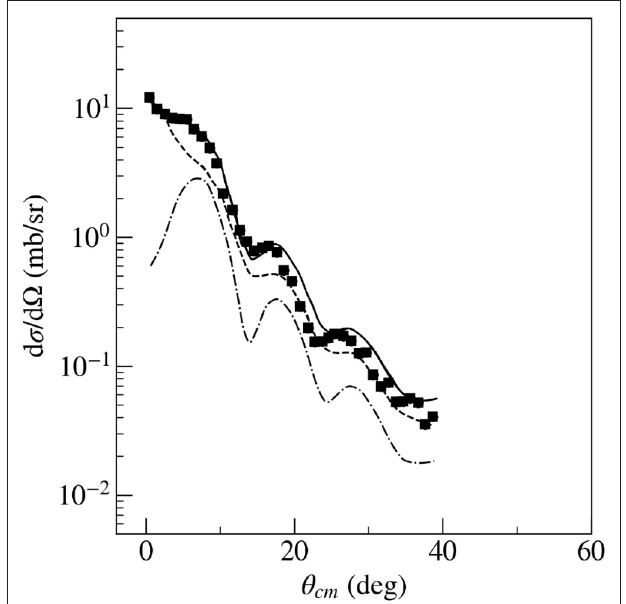
FIGURE 2 | The calculated angular distributions of the reaction 9 Be( 10 B, 9 Be) 10 B (g.s.) compared with the experimental data (black points). The DWBA fits for individual contributions of l = 0, 1, and 2 are represented by dashed, dotted, and dash-dotted lines, respectively. Calculations are performed with the optical potential 1 and the optical potential 2 gives the same fit.